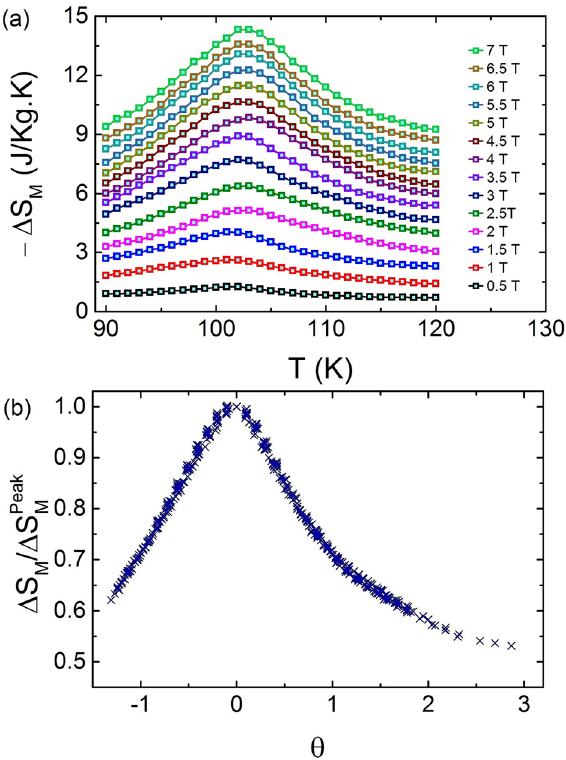
Figure 3. ( a ) The evolution of (cid:31) S M vs. T at different fields (0.5 → 7 T) determined by M–H curve [Fig. 2(b)], which shows a continuous nonmonotonic change of (cid:31) S M around T C . ( b ) Universal curve for TL-LSMO-0.3 shows the collapse of all (cid:31) S M on single curve, which is the characteristic of second-order phase transition. (Figures have been drawn using OriginPro 2015